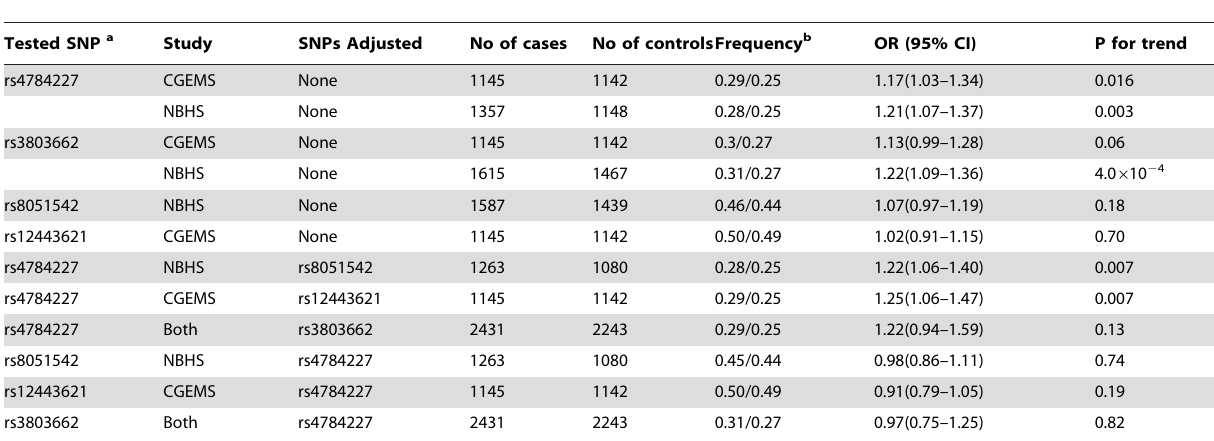
Table 5. Association of rs4784227 and the three previously-reported SNPs at 16q12with breast cancer risk among European American